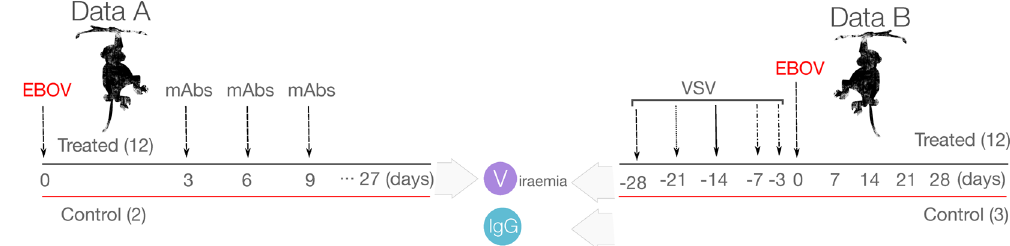
Figure 1. Experimental designs of the two data sources. The experiments were conducted in nonhuman primates (NHPs). The numbers in the parentheses are the sample size. The days zero indicate the time of Ebola virus infection. mAbs : time of monoclonal antibody treatments 10 ; VSV : time of vaccination with the recombinant vesicular stomatitis virus-Zaire EBOV (rVSV-EBOV) 11